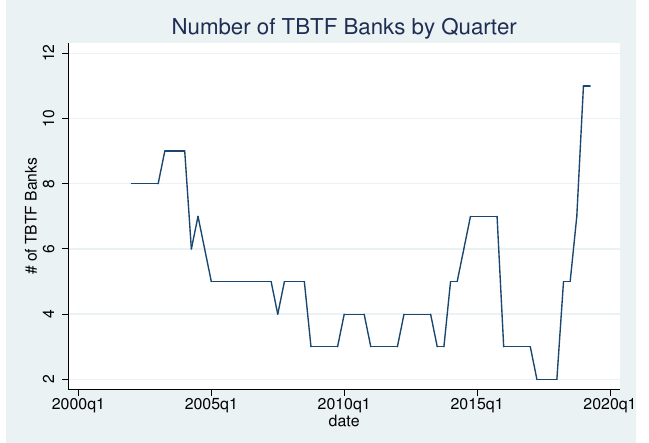
Figure A3. TBTF banks. This graph displays the number of TBTF time series by each